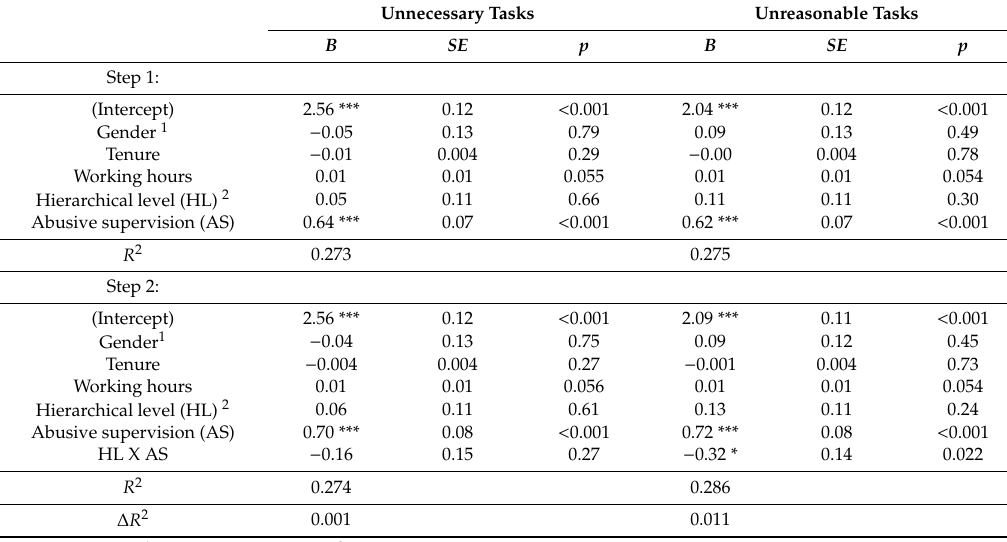
Table 2. Results of the regression